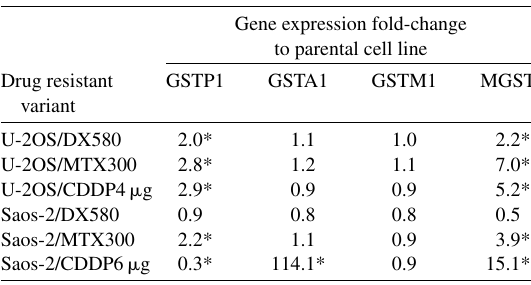
level, assessed with real-time PCR, was calibrated to normal human osteoblasts Gene expression fold-change to parental cell line